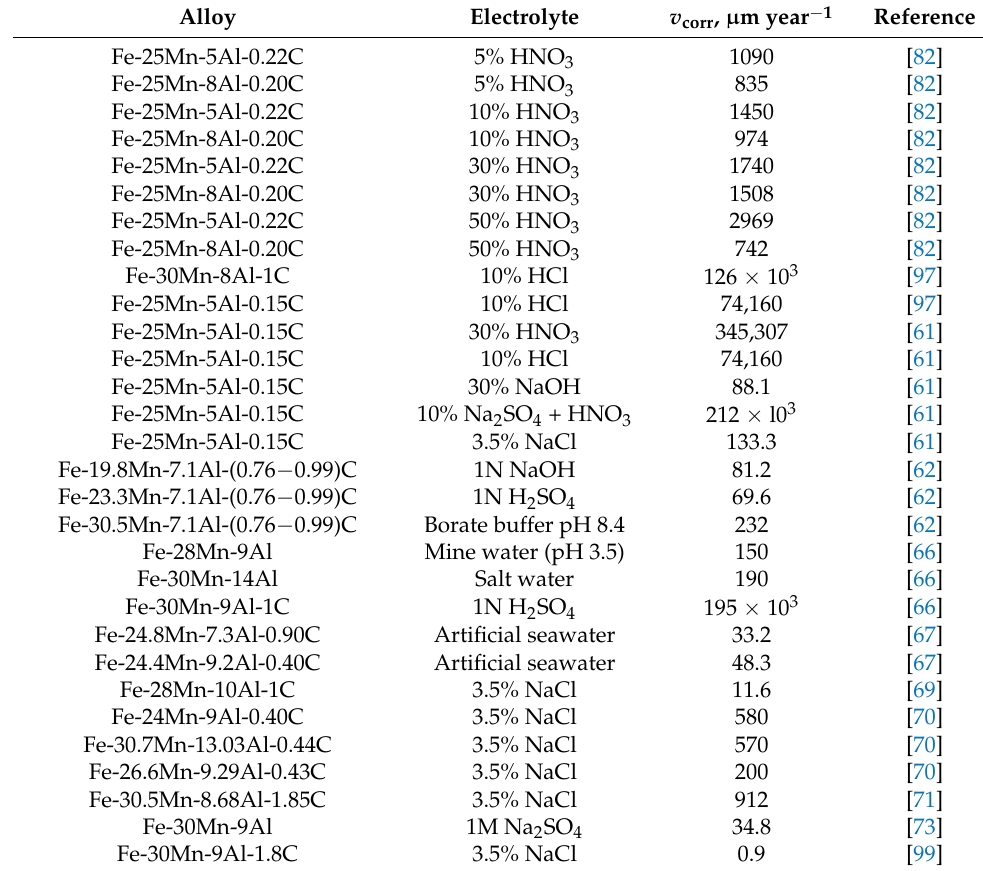
Table 2. Corrosion rate ( v corr ) ( µ m year − 1 ) values for high-Mn TWIP steels with aluminum alloying.